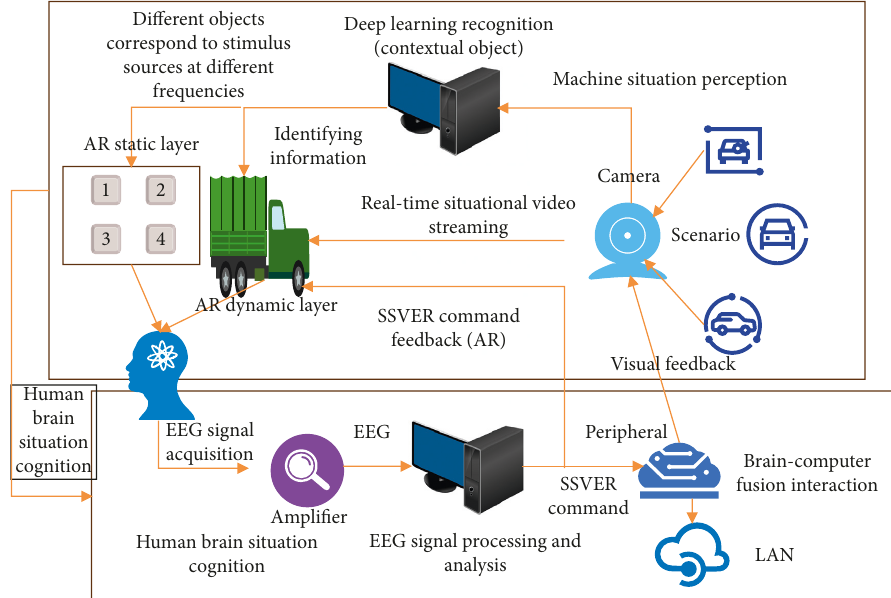
Figure 8: Schematic diagram of the brain-computer fusion interaction system driven by real situations.